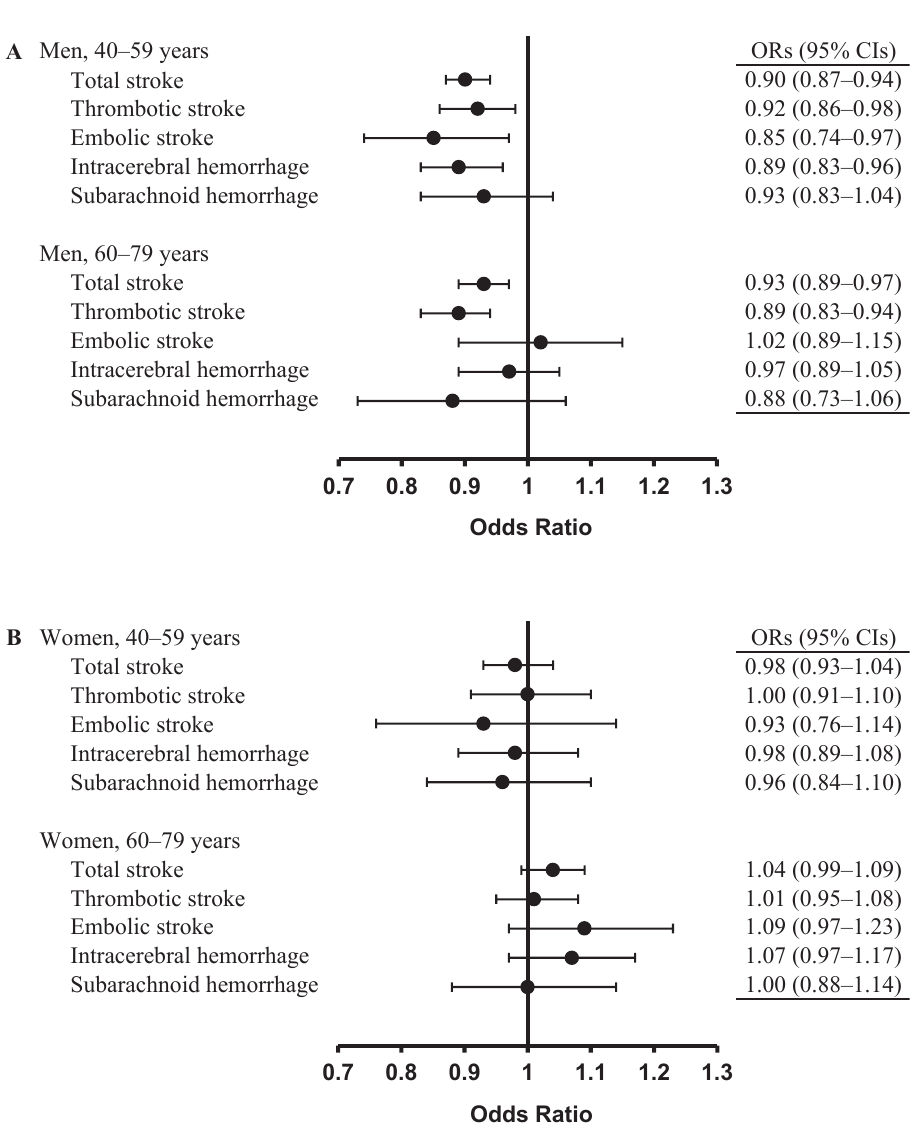
Figure 1. Multivariable-adjusted odds ratios and 95% con fi dence intervals of stroke and its subtypes for one standard deviation increase of height in men (A) and women (B). Odds ratios were matched for age and adjusted for body mass index, smoking, drinking, exercise, hypertension, hyperlipidemia and diabetes; OR, odds ratio; CI, con fi dence